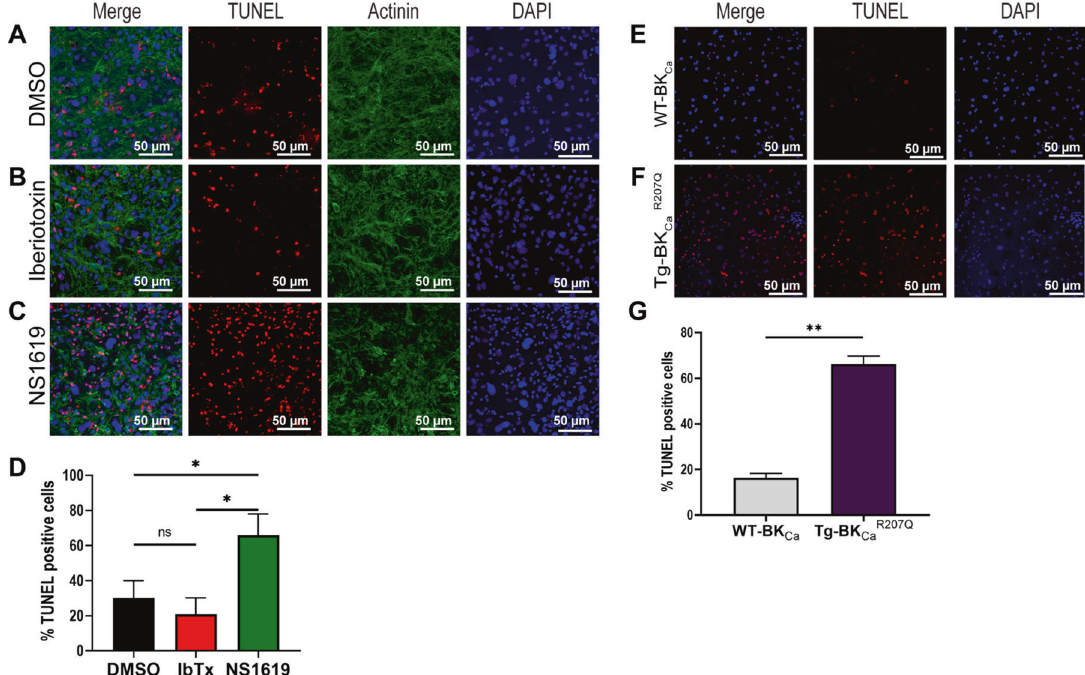
Fig. 5 Inhibition of BK Ca channel protects the neonatal cardiomyocytes from apoptotic damage post hypoxia injury. Isolated mouse neonatal cardiomyocytes were subjected to 6 h hypoxia at 1% O 2 , 5 min of post-conditioning with DMSO, Iberiotoxin (100 nM), or NS1619 (10 μ M) followed by 12 h of reoxygenation at 21% O 2 . Cells were fi xed and stained for TUNEL-positive nuclei (red), Actinin (green), and Nucleus (blue). A total of 100,000 cells were seeded per assay. B and D Cardiomyocytes post-conditioned with IbTx shows fewer TUNEL-positive nuclei compared to DMSO control ( A and D ). Cardiomyocytes post-conditioned with NS1619 exhibited a signi fi cantly higher number of TUNEL- positive nuclei compared to DMSO and IbTx ( D ). Cardiomyocytes isolated from E wild-type pups (WT-BK Ca ) or pups expressing F genetically activated BK Ca (Tg-BK CaR207Q ) were subjected to 6 h hypoxia at 1% O 2 followed by 12 h of reoxygenation at 21% O 2 . Cells were fi xed and stained for TUNEL-positive nuclei (red), and Nucleus (blue). Neonatal cardiomyocytes isolated from Tg-BK CaR207Q pups showed higher TUNEL- positive nuclei as compared to WT-BK Ca ( G ). Data represented as percentage TUNEL-positive cells ( D and G ) mean ± SEM from eight out of ten independent experiments. P -values were determined by a one-tailed unpaired student ’ s t -test followed by a non-parametric Mann – Whitney test for comparison between the ranks; ns is not signi fi cant, * ≤ 0.05, ** ≤